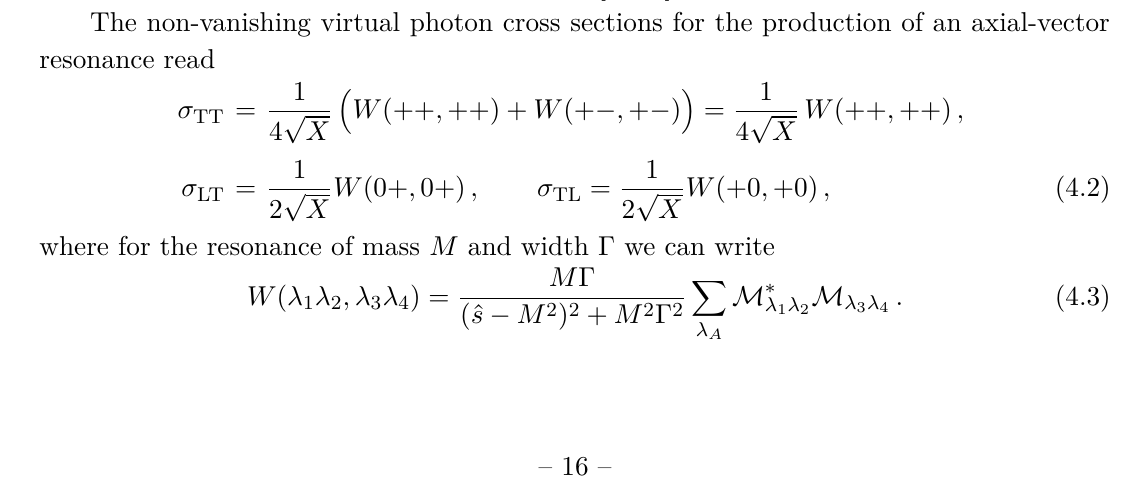
Figure 5 . Dependence of form factors F TT ( Q 2 Here we used the LFWF obtained from the power-like potential